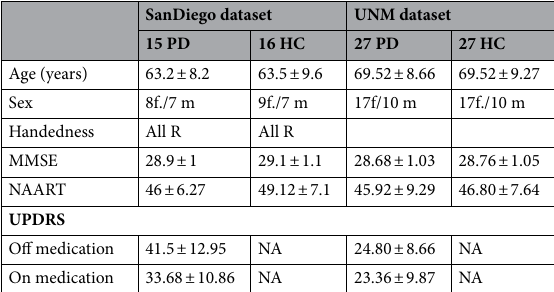
Table 2. Patient and control participant demographics (mean ± st).